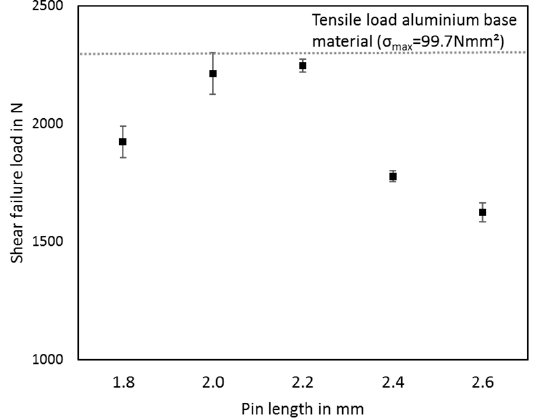
Figure 6. Influence of the pin length on the shear failure load.